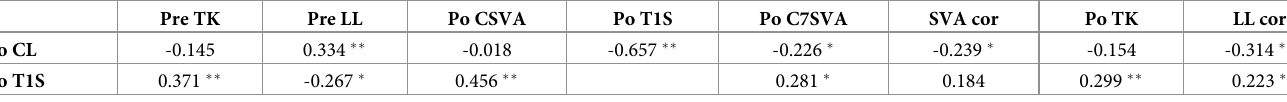
Data are presented as mean ± standard deviation, or number.